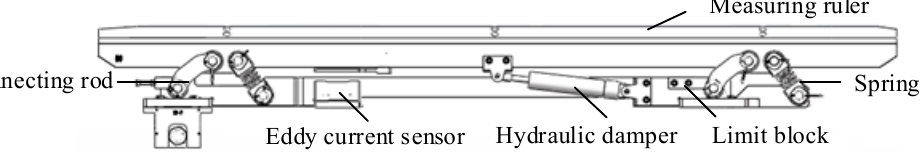
Figure 2. A schematic diagram of the parallelogram mechanism.